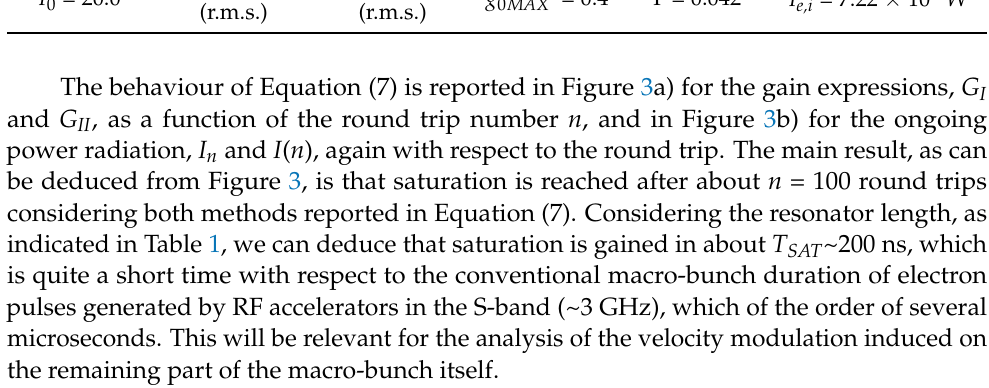
Table 2 . Cerenkov FEL Gain Parameters @ λ = 250 μm